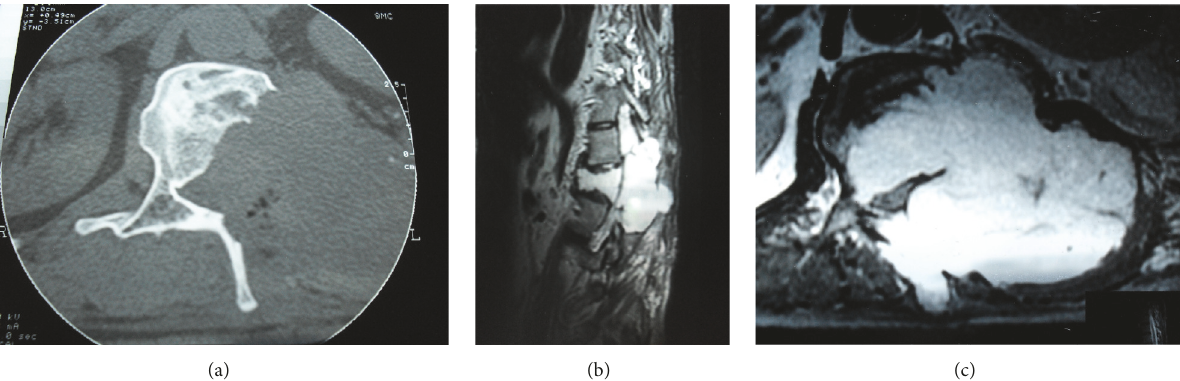
Figure 5: (a) CT: the destruction of the L1 vertebra, compared to Figure 2(b), has obviously become more important. (b) MRI, sagittal T 2 WI: the kyphotic deformity is evidently more prominent. (c) MRI, axial T 1 WI, with gadolinium: the dimensions of the hemangioma have clearly increased; the destruction of the L1 vertebra has obviously become more important.